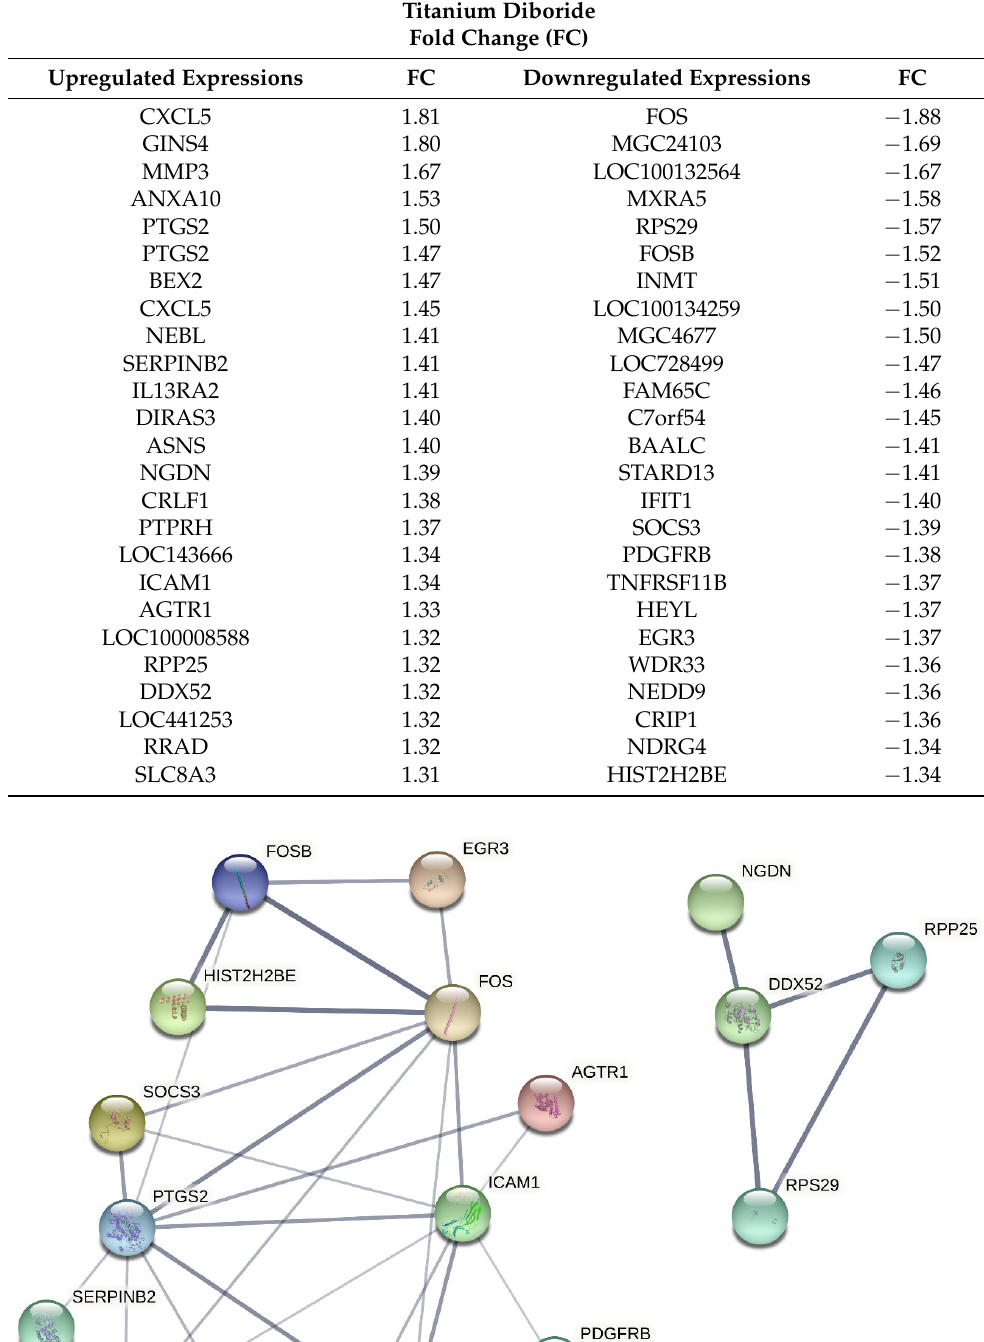
Table 1. Gene expression changes with respect to titanium diboride (TiB 2 ) NPs application.